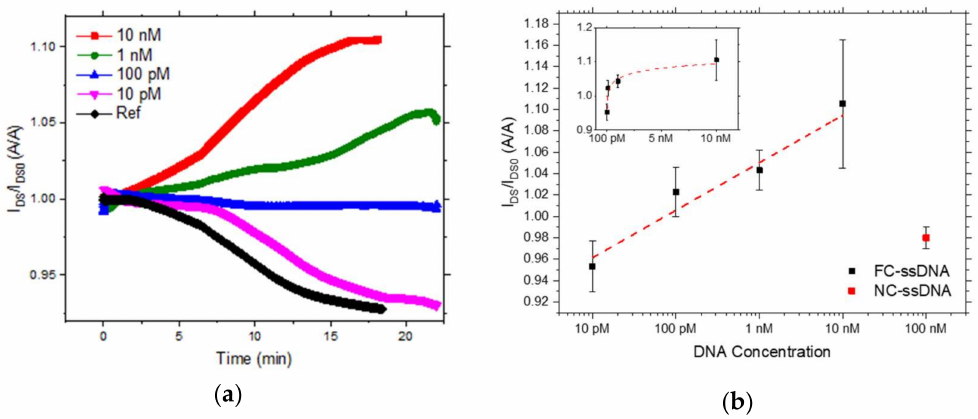
Figure 3. ( a ) Output current of a sensor after the addition of 10 nM (red curve), 1 nM (green curve), 100 pM (blue curve), 10 pM (purple curve) of FC-ssDNA and of the sole TRIS buffer solution without the FC-ssDNA (black curve). ( b ) Output current variation of the sensor, normalized with respect to their baseline current, as a function of target ssDNA concentration (FC-ssDNA, black square and NC-ssDNA, red square). The inset reports the output current variation as a function of the FC-ssDNA in a linear